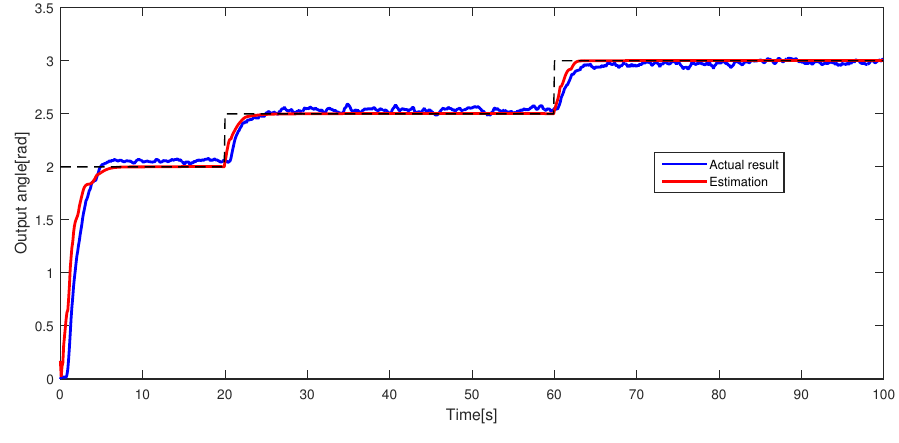
Figure 15. The result of the proposed method.